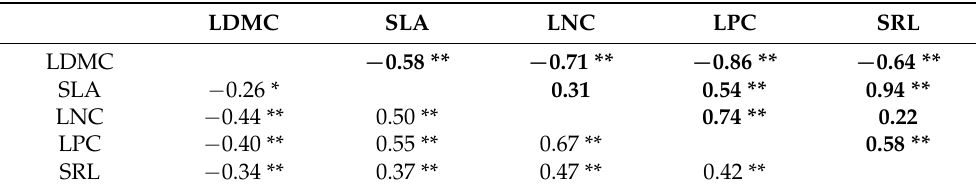
Table 3. Correlations among functional traits and among community-weighted means of traits for four restoration communities.